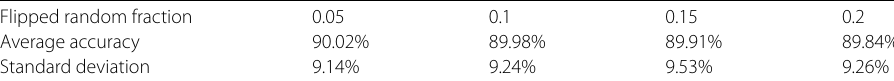
Table 3 Average and standard deviations of BiLSTM-RSSI reconstruction method trained on GT1 after introducing random noise of various levels. Average values are computed over 20 independent